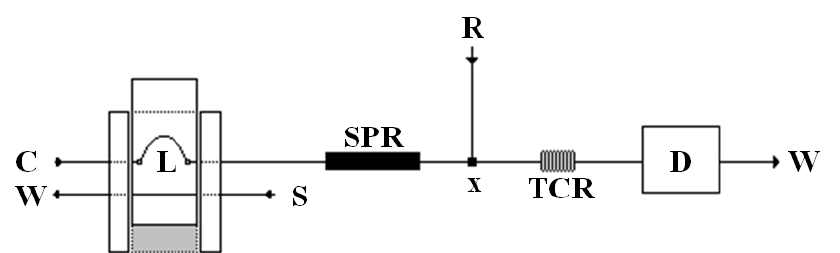
Figure 2. Schematic diagram of the flow system used for evaluation of the FIA manifold employed for dipyrone determination. C – Carrier solution (deionized water with a flow rate of 1.7 mL min -1 ); S - sample or reference solutions (sample volume of 100 m L); SPR – Solid-phase reactor (12 cm × 2.0 mm i.d.); R – Reagent solution (alizarin red S 0.020% (m/v) with a flow rate of 0.5 mL min -1 ); x – confluence point; TCR – tubular coiled reactor (75 cm); D – detector ( l = 540 nm); W -